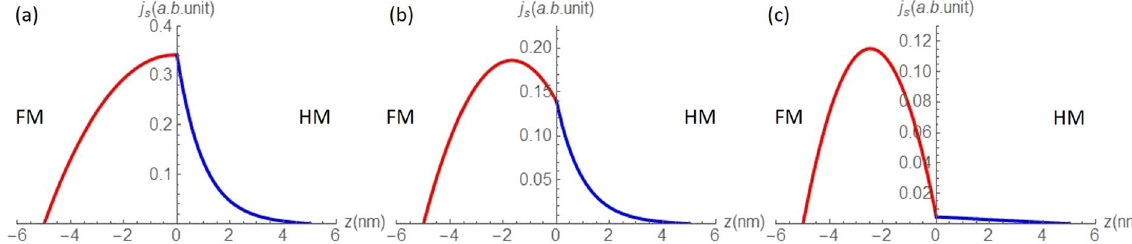
Figure 5. ( a ) Calculated spin current distribution for a FM/HM (Pt) bilayer in longitudinal configuration, where λ = nm 1 HM ( b ) Calculated spin current distribution for a FM/HM (Ta) bilayer in longitudinal configuration, where λ = nm 1 HM ( c ) Calculated spin current distribution for a FM/LM (Cu) bilayer in longitudinal configuration, where λ